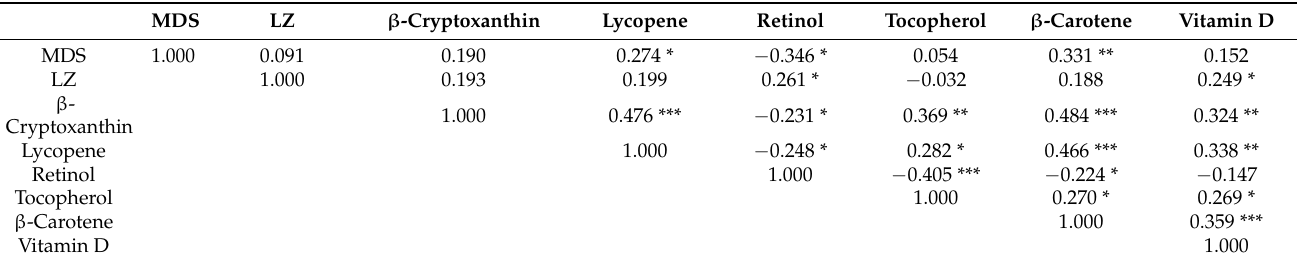
Table 2. Correlation (r) of MDS with lipid-soluble micronutrients.